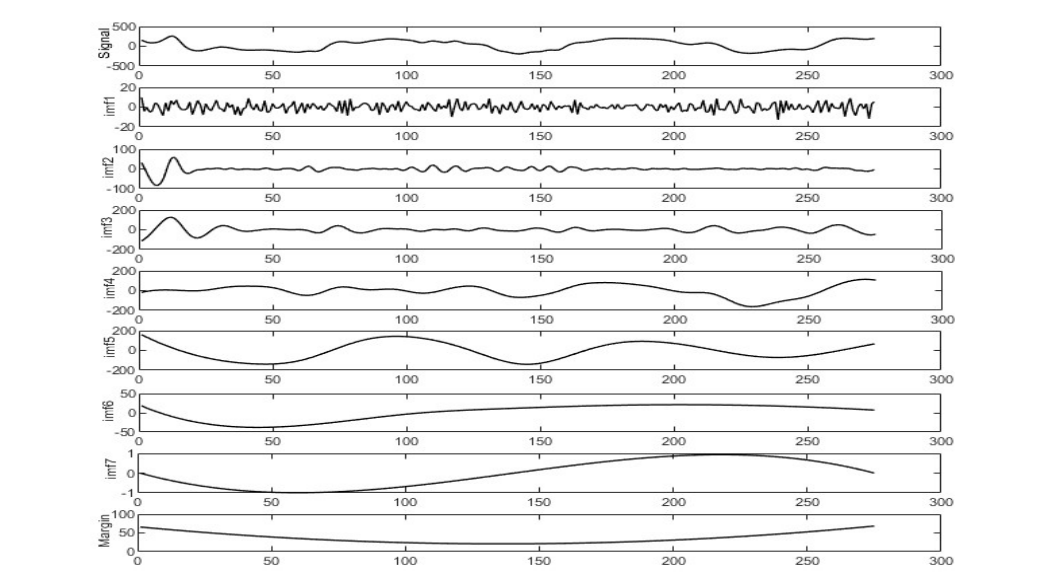
Figure.6 IMF diagram of the horizontal displacement observation of the Xiaolangdi dam crest